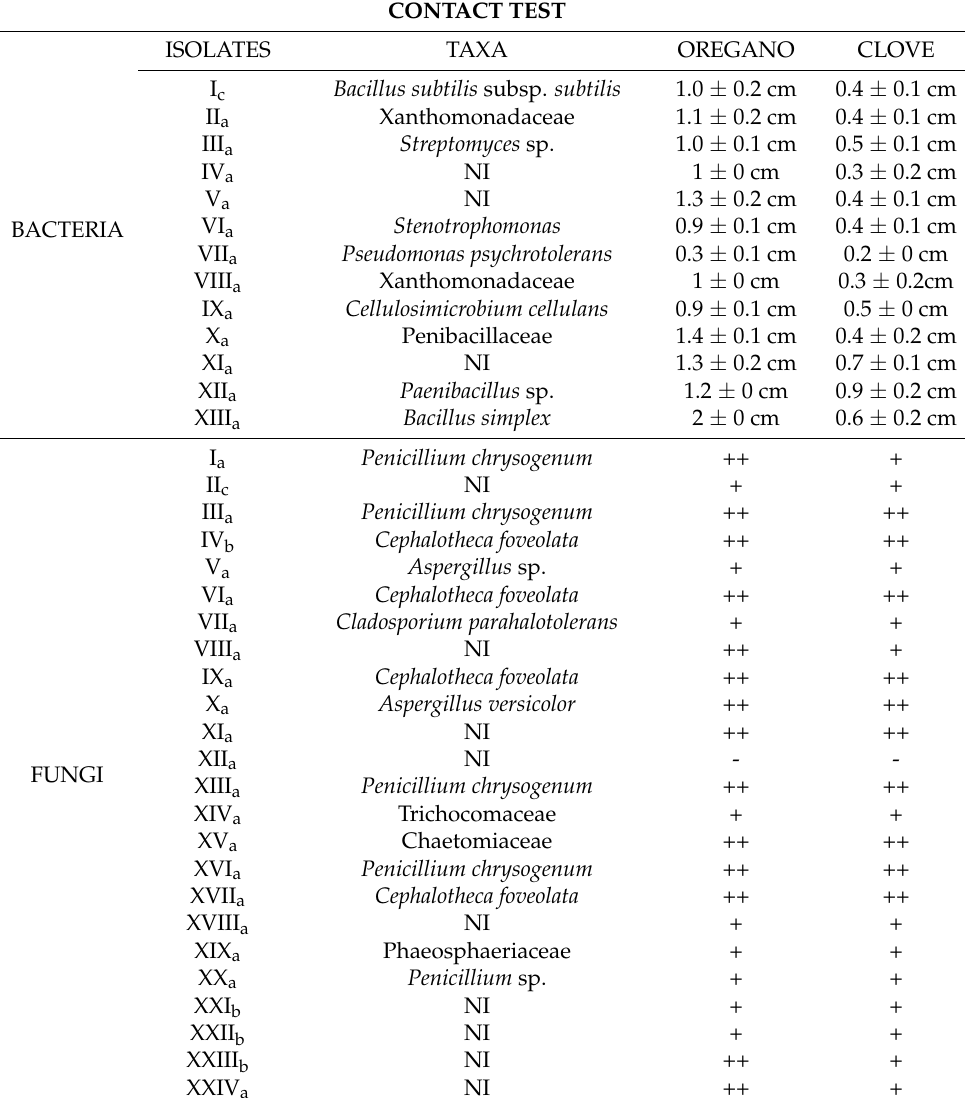
Table 1. Inhibition halo of oregano and clove essential oils on bacteria and fungi in contact tests. Tests were performed in duplicate and standard deviation was calculated. NI = not identified